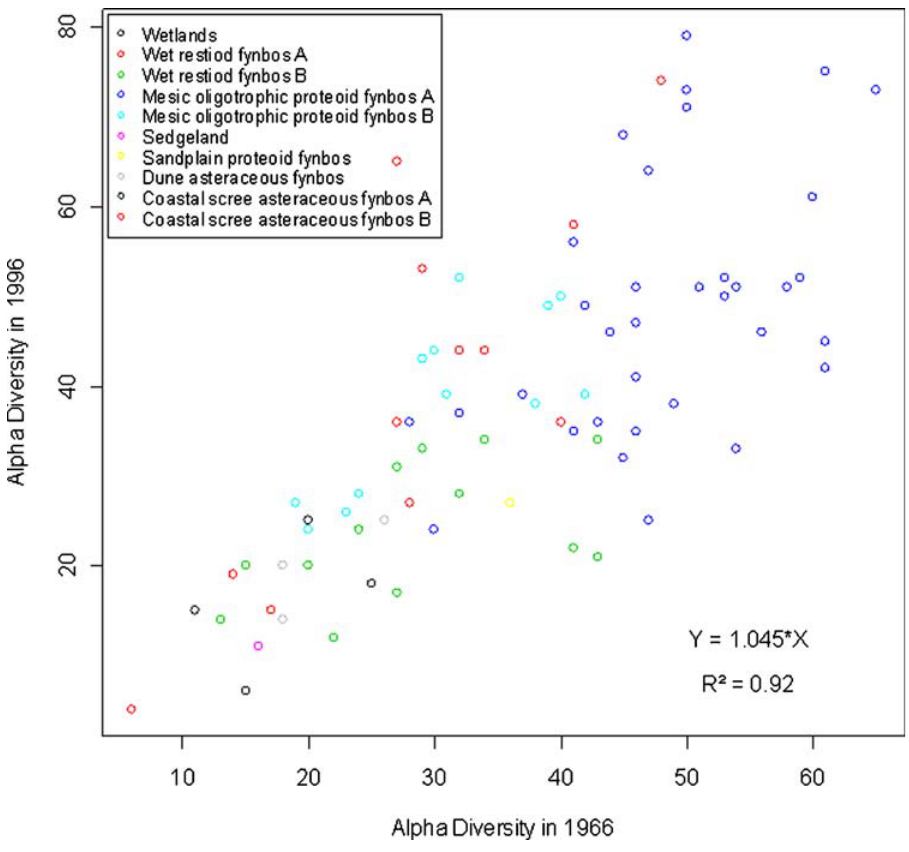
Figure 2. Relationship between alpha diversity measured in 1966 and in 1996.